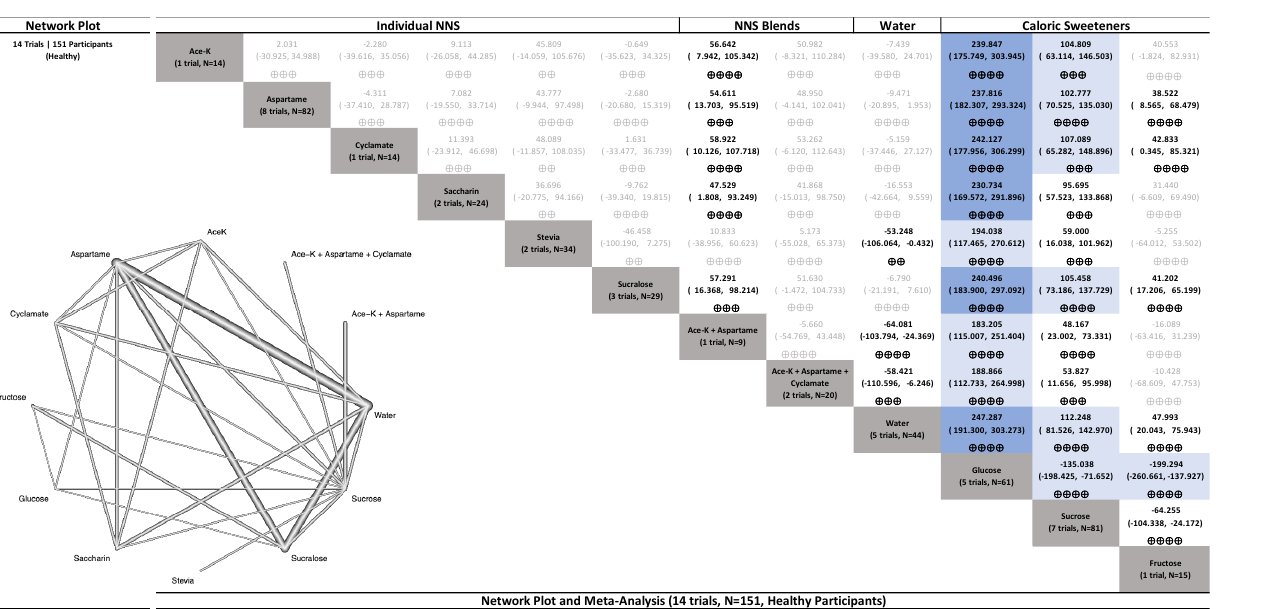
Figure 1. Network plot and meta-analysis of uncoupling interventions evaluating the effect of non-nutritive sweetened beverages (NNS beverages) sweetened single or blends of non-nutritive sweeteners (NNS), water, and sugar-sweetened beverages (SSBs) sweetened with caloric sweeteners on postprandial blood glu- cose response in healthy participants. Network plot: the size of the nodes is proportional to the number of participants and the line width is proportional to the number of studies. Network table: treatments are grouped by treatment type (i.e., single NNS, NNS blends, water, and caloric sweeteners) and are reported in alphabetical order. Treatment estimates (mmol*min/L) are MDs and 95% CIs of the column-defining treatment compared with the row-defining treatment. MDs less than 0 favor the column-defining treatment. MDs greater than 0 favor the row-defining treatment. Statistically significant results are bolded in black. Results that are not statistically significant are grey and not bolded. The minimally important difference (MID) for postprandial glucose response is 100 mmol*min/L. Trivial effects (<1 MID) or no effects have a white background; small important effects (>1 MID) have a light blue background; moderate effects (>2 MID) have a darker blue background; large effects (>5 to <10 MID) have a purple background; and very large effects (>10 MID) have a black background. Confidence in the effect estimate (CINeMA) is shown for each treatment comparison: high confidence ⊕⊕⊕⊕ ; moderate confidence ⊕⊕⊕ ; low confidence ⊕⊕ ; and very low confidence ⊕ . See Supplementary Table S6 for overall CiNEMA assessments and Supplementary Figures S6 – S9 for detailed assessments of the confidence in the effect estimate using the CINeMA framework.